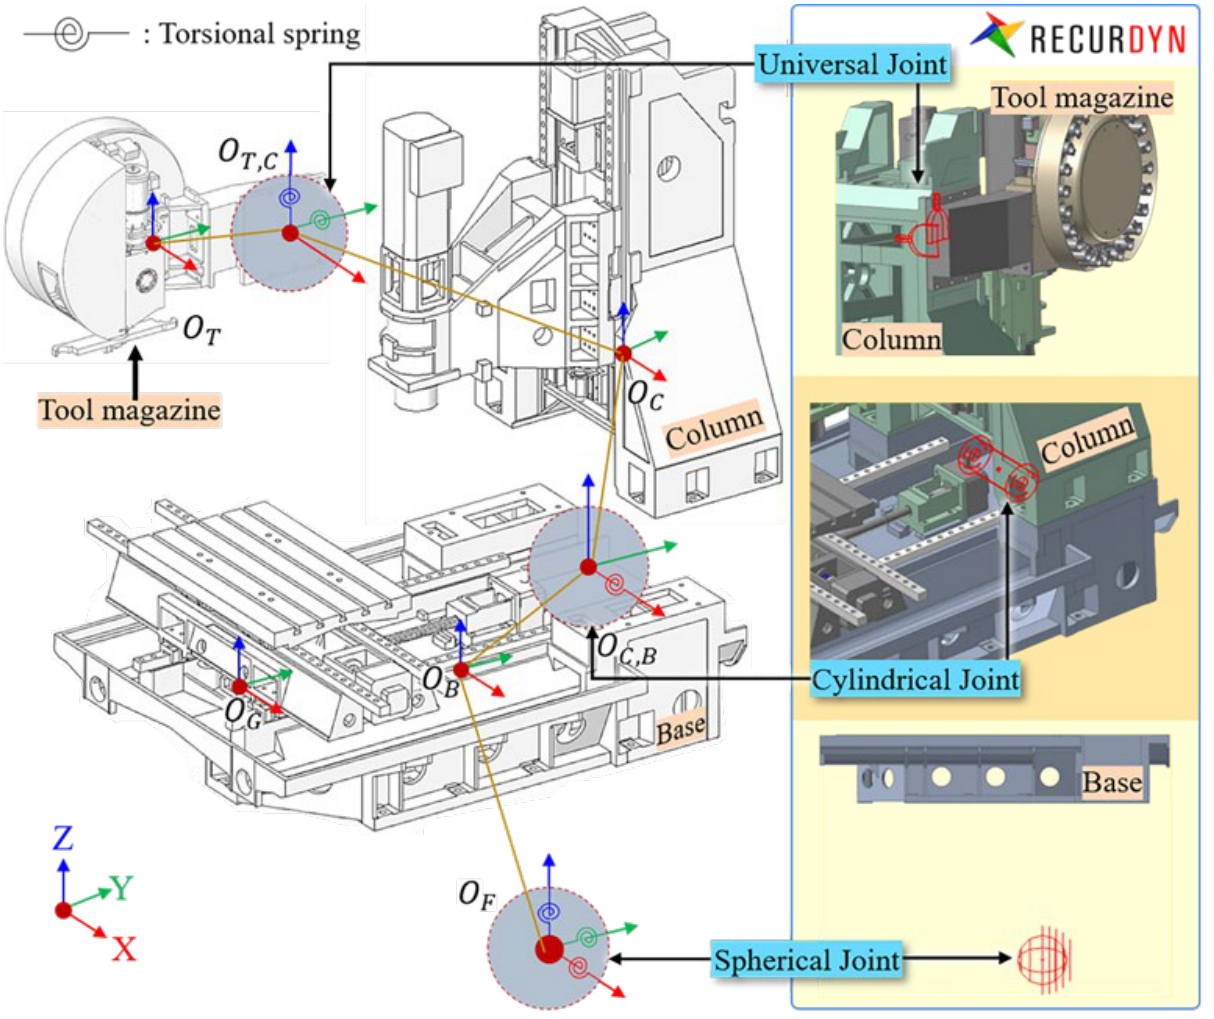
Table 3. Joints setting position.